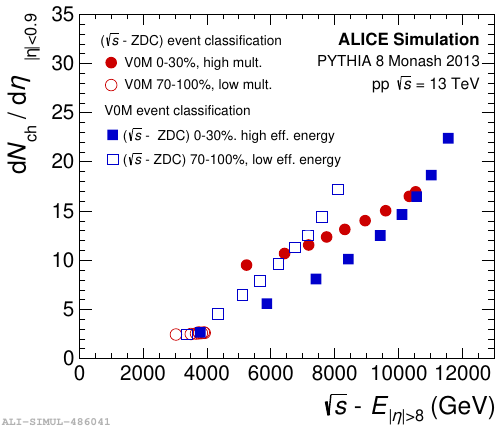
Figure 4: Multiplicity and effective energy correlation in PYTHIA 8 using V0-ZDC combined classes.